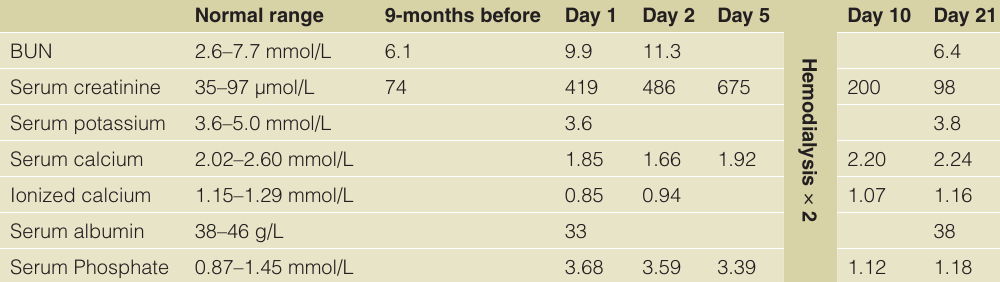
Table 1. Showing the hospital course of the patient. Normal